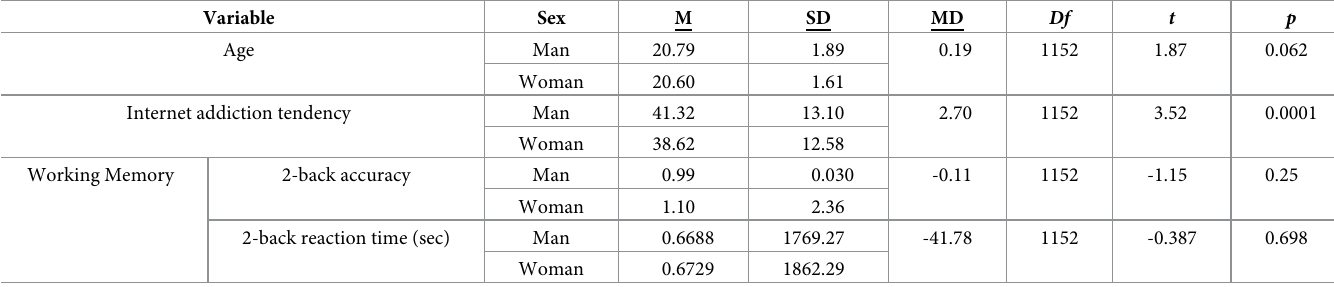
lated with brain activity during the 2-back task in the medial frontal gyrus, superior frontal gyrus, and medial part of the ACC (Table 5 and Fig 5). This cluster of significant correlation mostly belonged to areas that were deactivated during the 2-back task (Table 5). Table 2. Comparison of IAT scores between men and women. Variable Sex M SD MD Age Man Internet addiction tendency